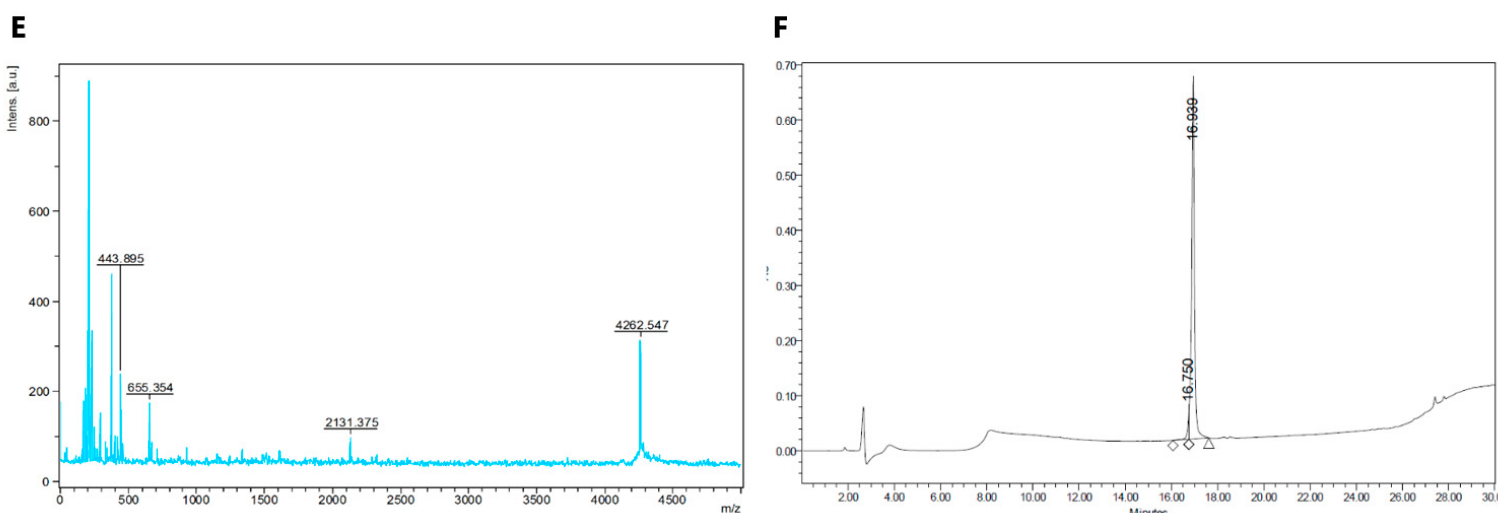
Figure 1. MALDI-TOF-MS and analytical HPLC of human α -calcitonin gene-related peptide (h- α -CGRP) ( 1 ) and [Lys 35 (Ahx-CF)] h- α -CGRP ( 3 ). ( A ) MALDI-TOF-MS of h- α -CGRP before oxidation and purification; ( B ) MALDI-TOF-MS and ( C ) analytical HPLC of h- α -CGRP ( 1 ) after oxidation and purification; ( D ) MALDI-TOF-MS of [Lys 35 (Ahx-CF)] h- α -CGRP ( 3 ) before oxidation and purification; ( E ) MALDI-TOF-MS and ( F ) analytical HPLC of [Lys 35 (Ahx-CF)] h- α -CGRP ( 3 ) after oxidation and purification. Calculated masses: reduced CGRP, 3791.373; oxidized CGRP, 3789.357 Da; reduced [Lys 35 (Ahx-CF)] h- α -CGRP, 4262.838 Da; oxidized [Lys 35 (Ahx-CF)] h- α -CGRP, 4260.822 Da.